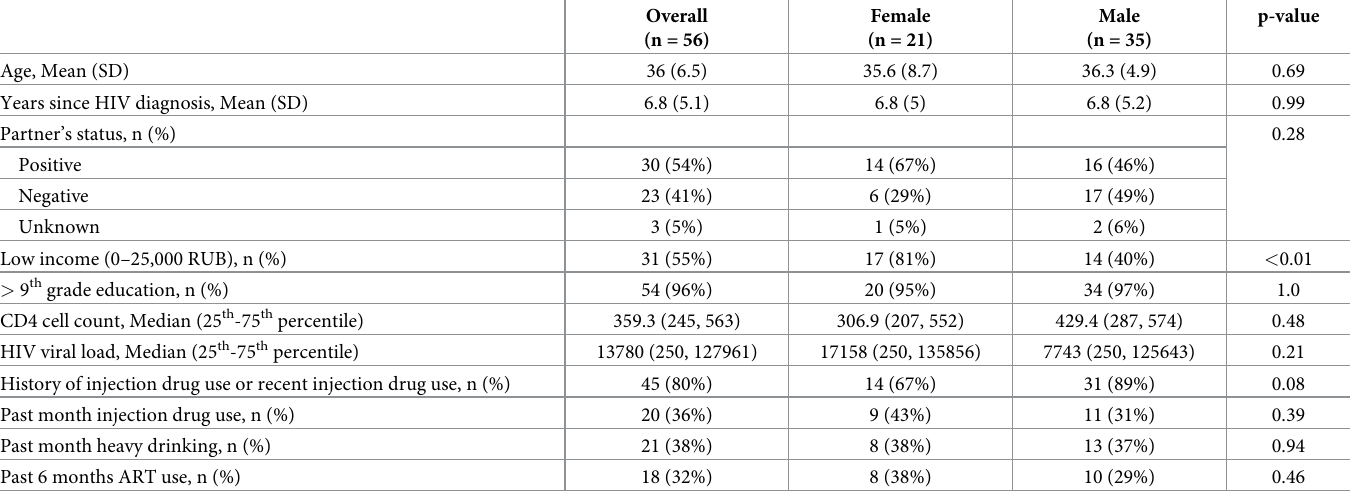
Table 3. Characteristics of a sub-sample of participants who reported being partnered (n =